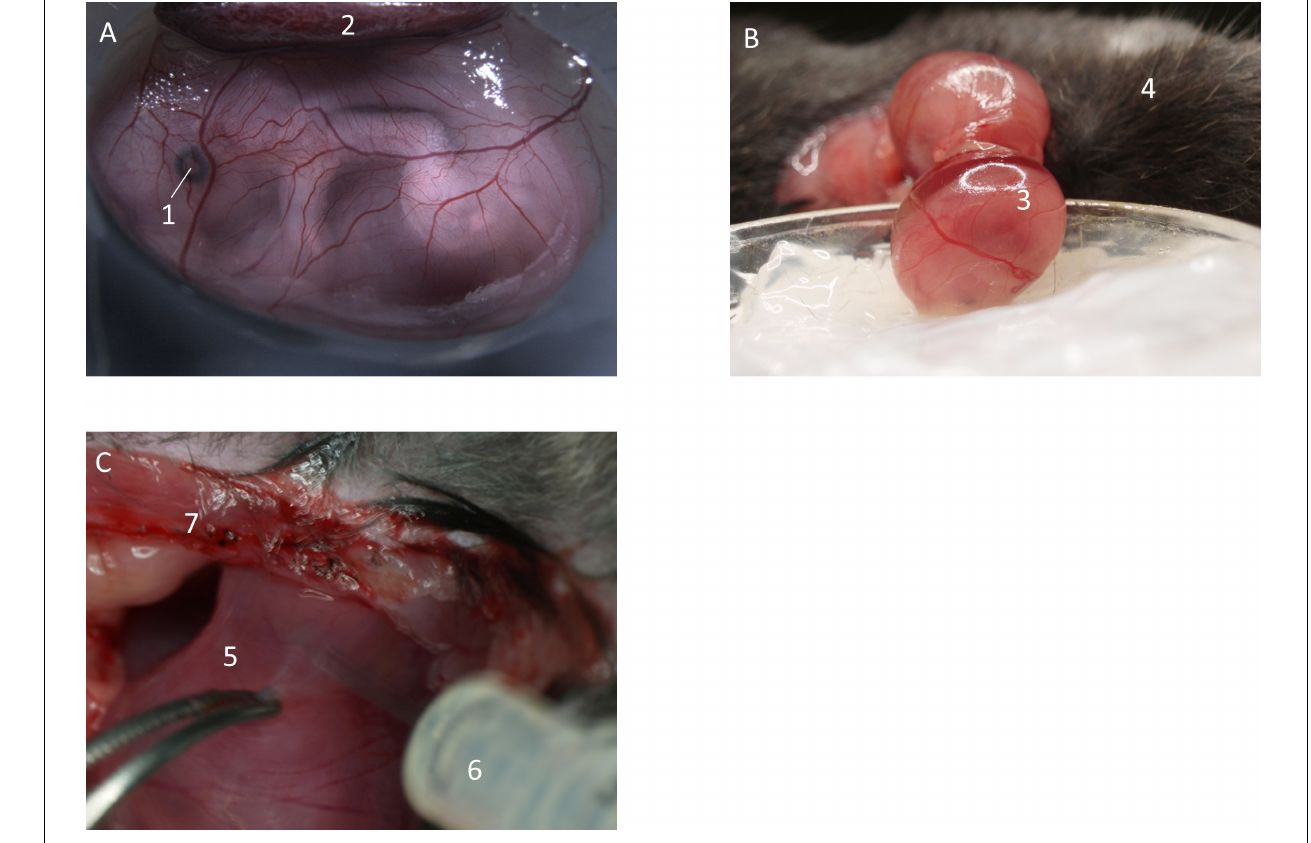
FIGURE 2 | Preparation of fetal yolk-sac. (A) Preparation allows access to the yolk-sac microvasculature. Image from Margraf (2018). (B) Following incision of the uterus, the fetus inside the yolk-sac is carefully mobilized and placed in a modified petri dish filled with medical silicone gel and superfusion buffer. (C) If needed, inflammatory stimuli can be injected into the uterus by puncturing in-between two separate fetuses. (1) Eye of the fetus. (2) Placenta. (3) Fetus inside yolk-sac. (4) Mother animal. (5) Uterus horn in-between two fetuses. (6) Syringe. (7) Abdominal opening of the mother